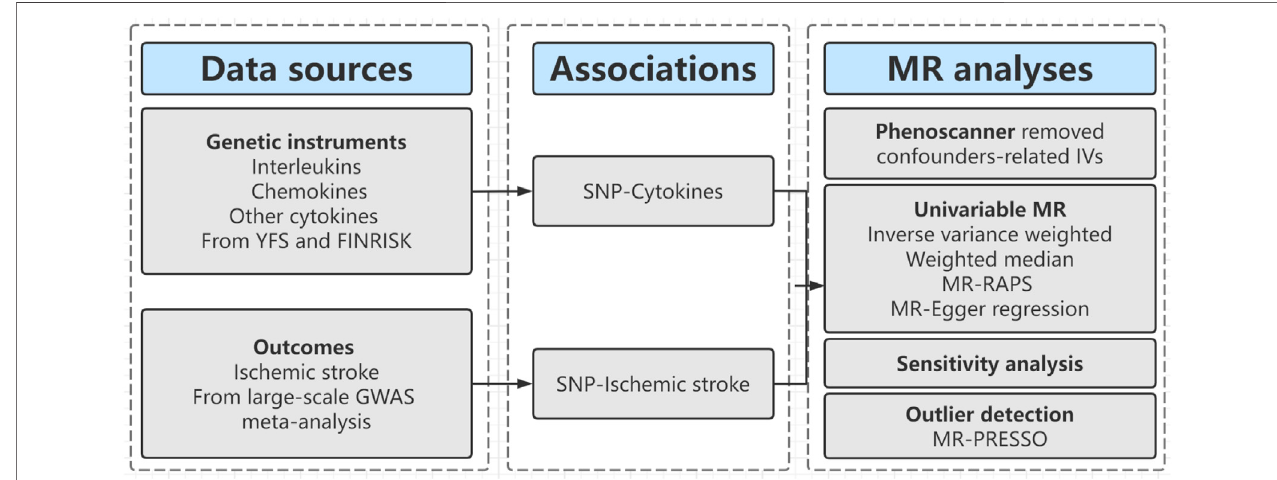
FIGURE 1 | Diagram of Mendelian randomization framework in this